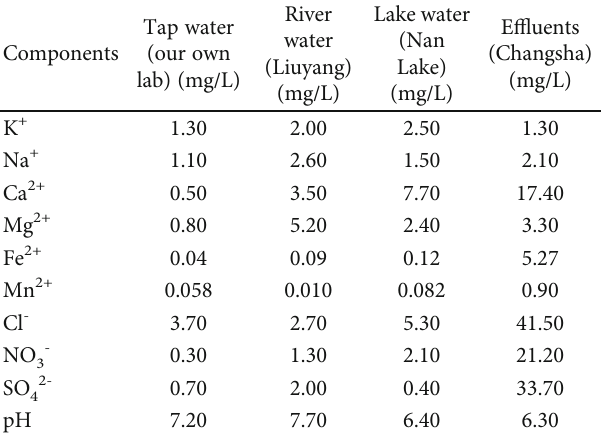
Table 3: Characterization of collecting water samples.